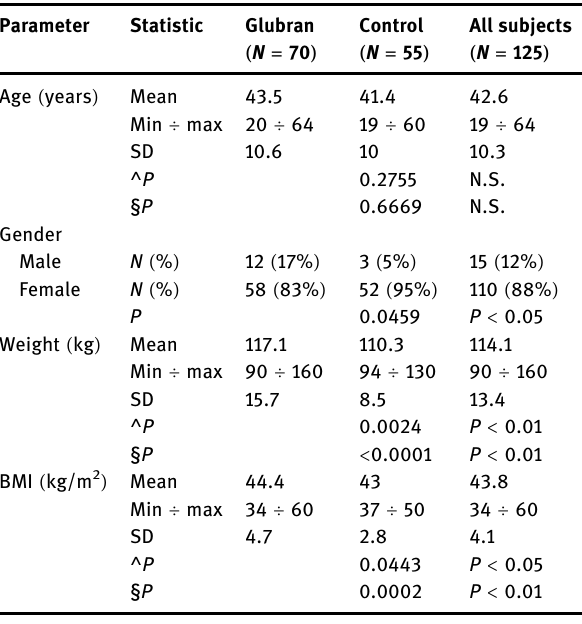
Table 1: Demographic features of group 1 and group 2 patients ( n = 125